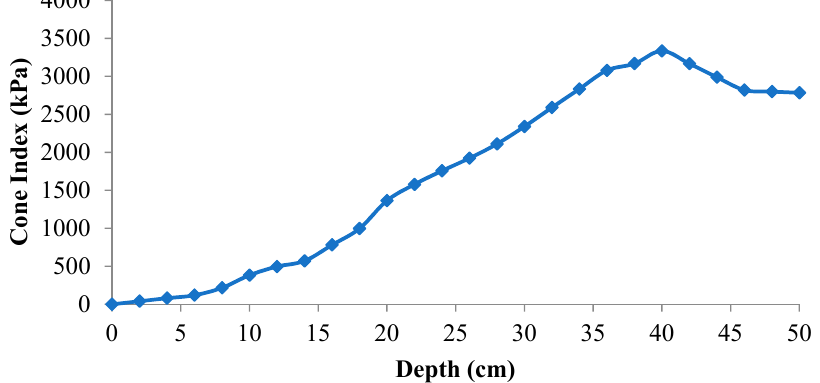
Table 1. Data obtained from field soil analysis.